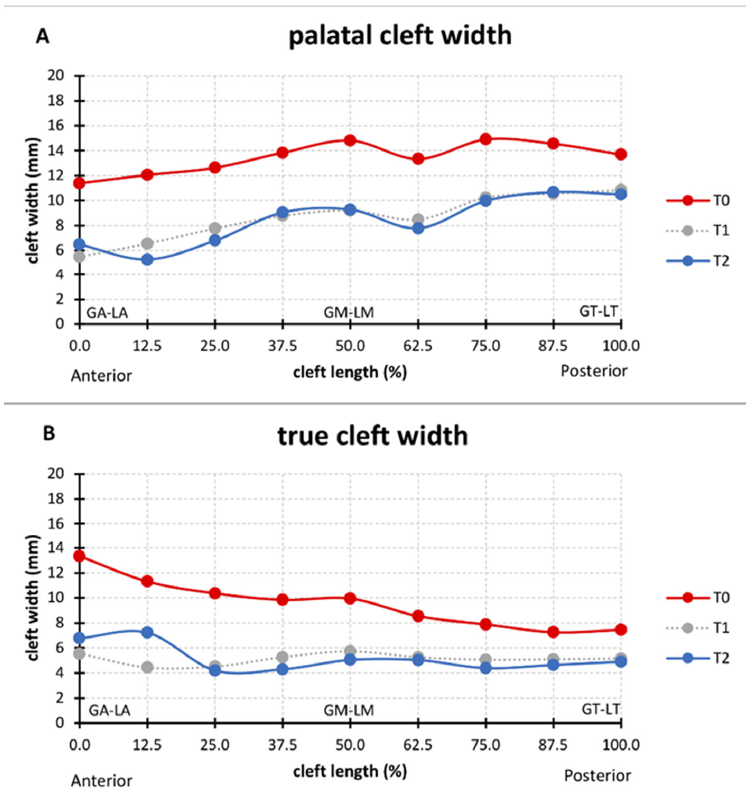
Figure 4. Median ( A ) palatal cleft width (PCW) and ( B ) true cleft width (TCW) before passive